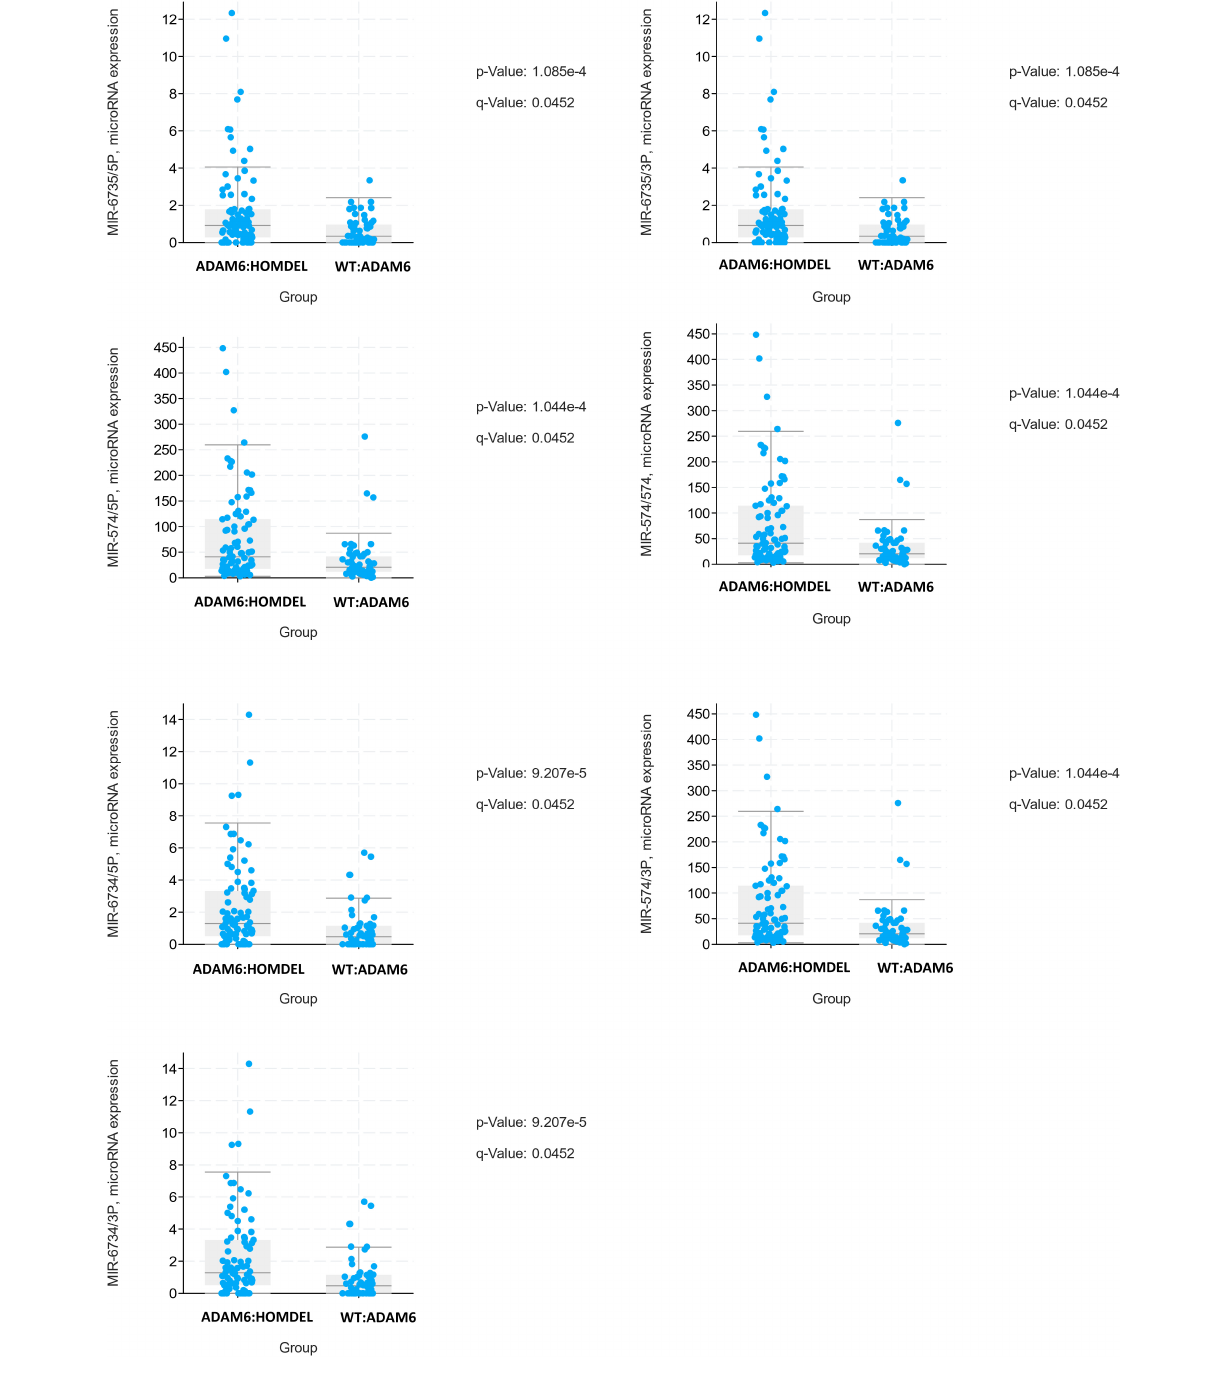
commonly deleted genes, the DEGs, and the shared miRNA targets. Our findings identified the common genes as PRSS1 , ACOT11 , NTRK2 , NOVA2 , and SEMA7A, suggesting that they might be the novel players in ADAM6 HOM:DEL ALL as shown in Figure 8